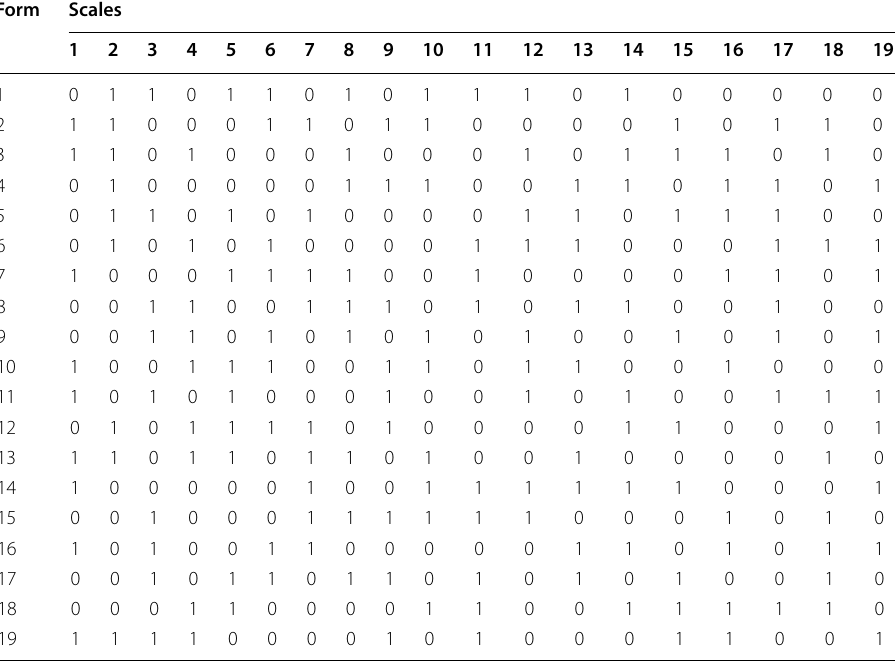
Table 4 Partially balanced incomplete block design for the 19 questionnaire